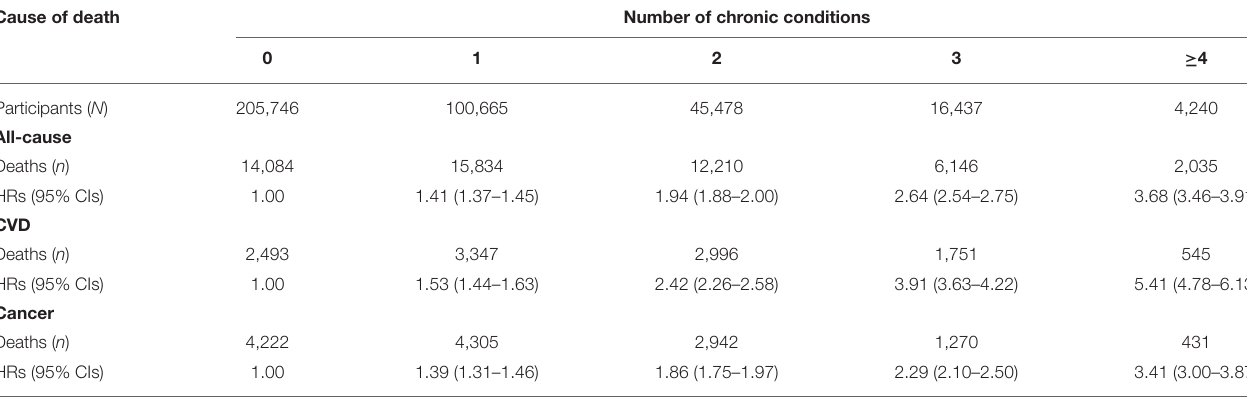
TABLE 2 | Association of the number of chronic conditions with all-cause and cause-specific mortality. Cause of